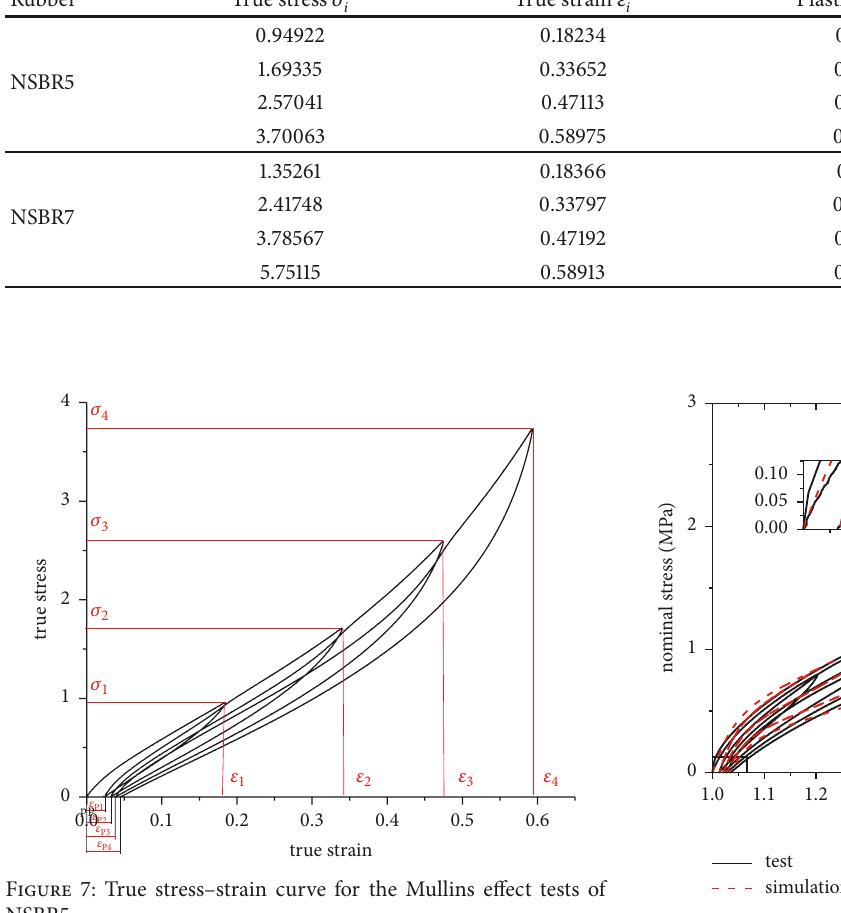
Figure 8: Experimental and simulation results of NSBR5 for the Mullins effect with the permanent set.